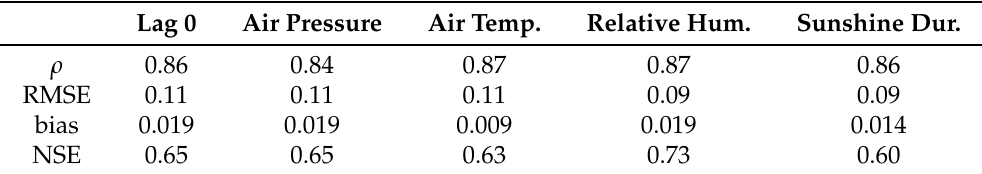
Table 3. Performance of Neural Network models where the dimension of the input feature space of the Lag 0-Model is expanded by adding another meteorological variable, i.e., air pressure, air temperature, relative humidity, or sunshine duration.